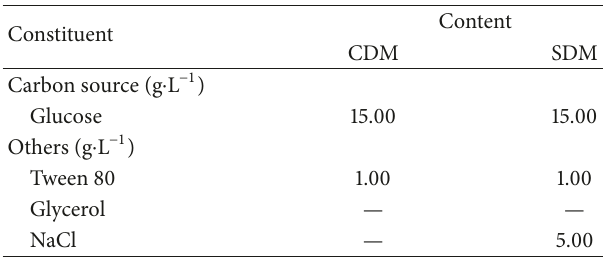
Table 1: Composition of CDM and SDM